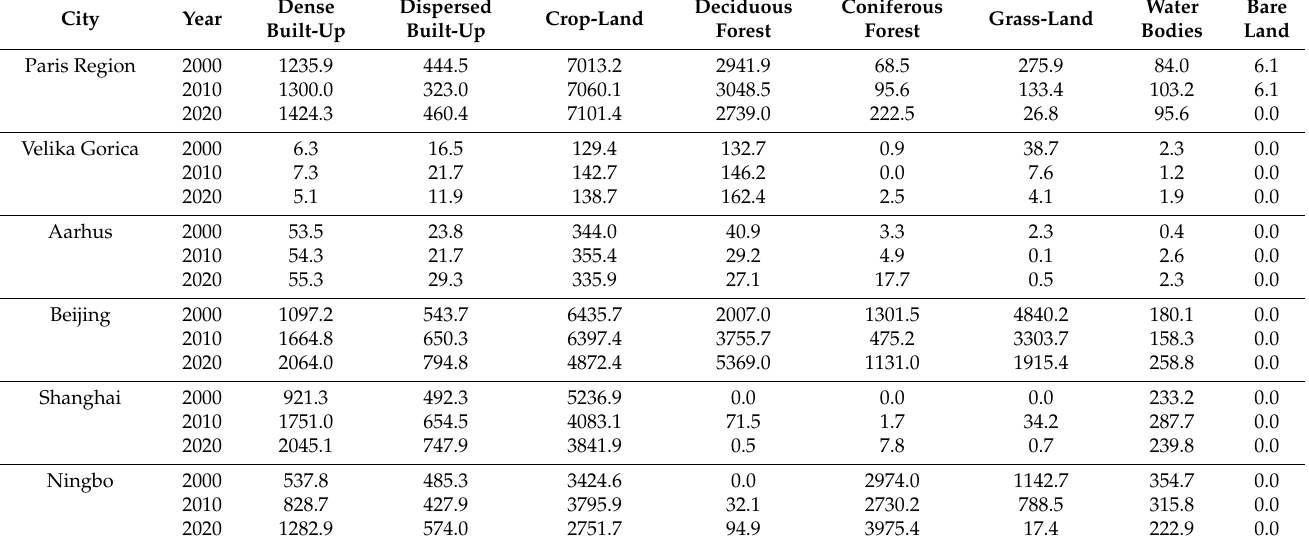
Table 5. Area statistics of LULC in 2000, 2010 and 2020 in km 2